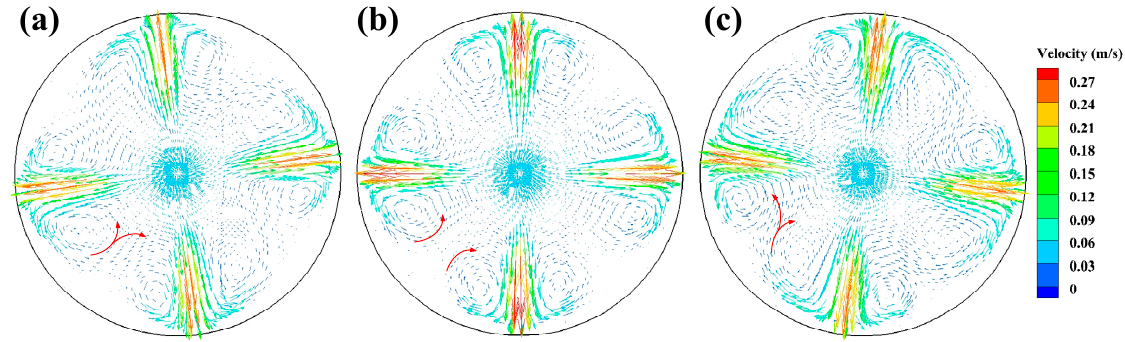
Figure 8. Velocity vector on the plane Z = 0.2 m without M-EMS ( a ) –15° SFN, ( b ) 0° SEN, and ( c ) +15° SFN.